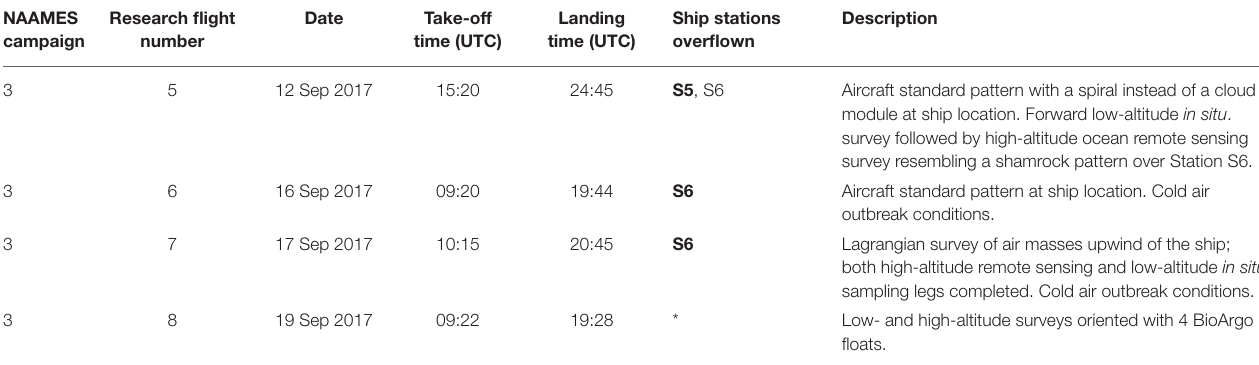
Take-off and landing times are shown for each research flight (RF). The ship stations overflown during each flight are also given, where contemporaneous overflight of the R/V Atlantis is given in bold, an asterisk denotes that the aircraft did not overfly the R/V Atlantis, and a dagger indicates that the aircraft overflew the R/V Atlantis as it transited from one station to the next.